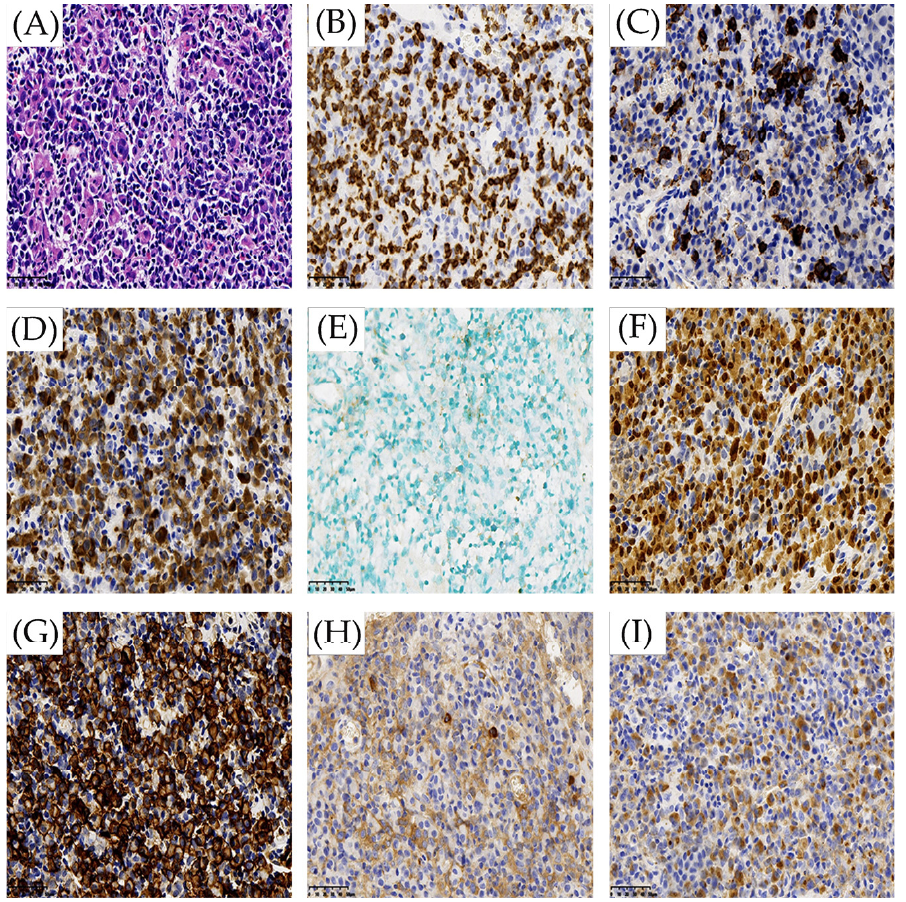
Figure 4. ( A – I ) Immunohistochemistry and in situ hybridization with Epstein-Barr virus-encoded